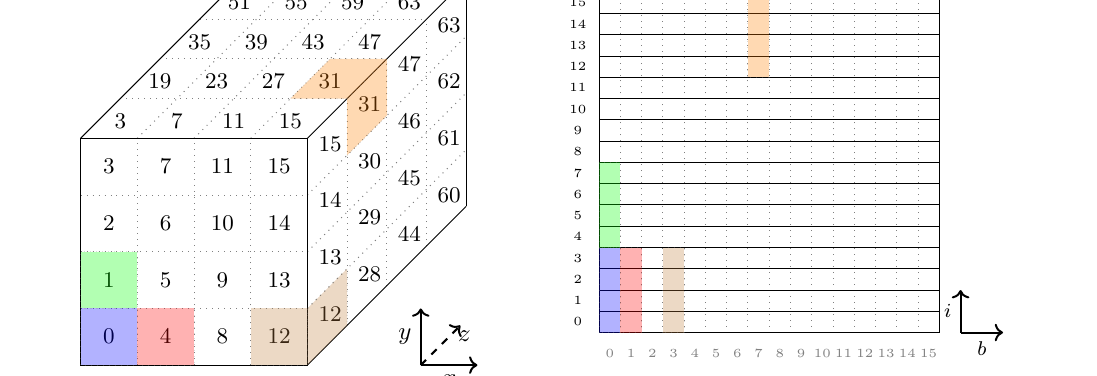
𝑥𝑧𝑦 (b) As sixteen 16-bit registers. The indices (a) As a 4 × 4 × 4 cube of 4-bit nibbles. The and boundaries of the registers are in black, boundaries between the nibbles are in gray. those of the bits are in gray. Figure 1: The 3-dimensional and 2-dimensional representations of the 256-bit state of Saturnin . Nibbles and their corresponding bits are represented with the same color in each